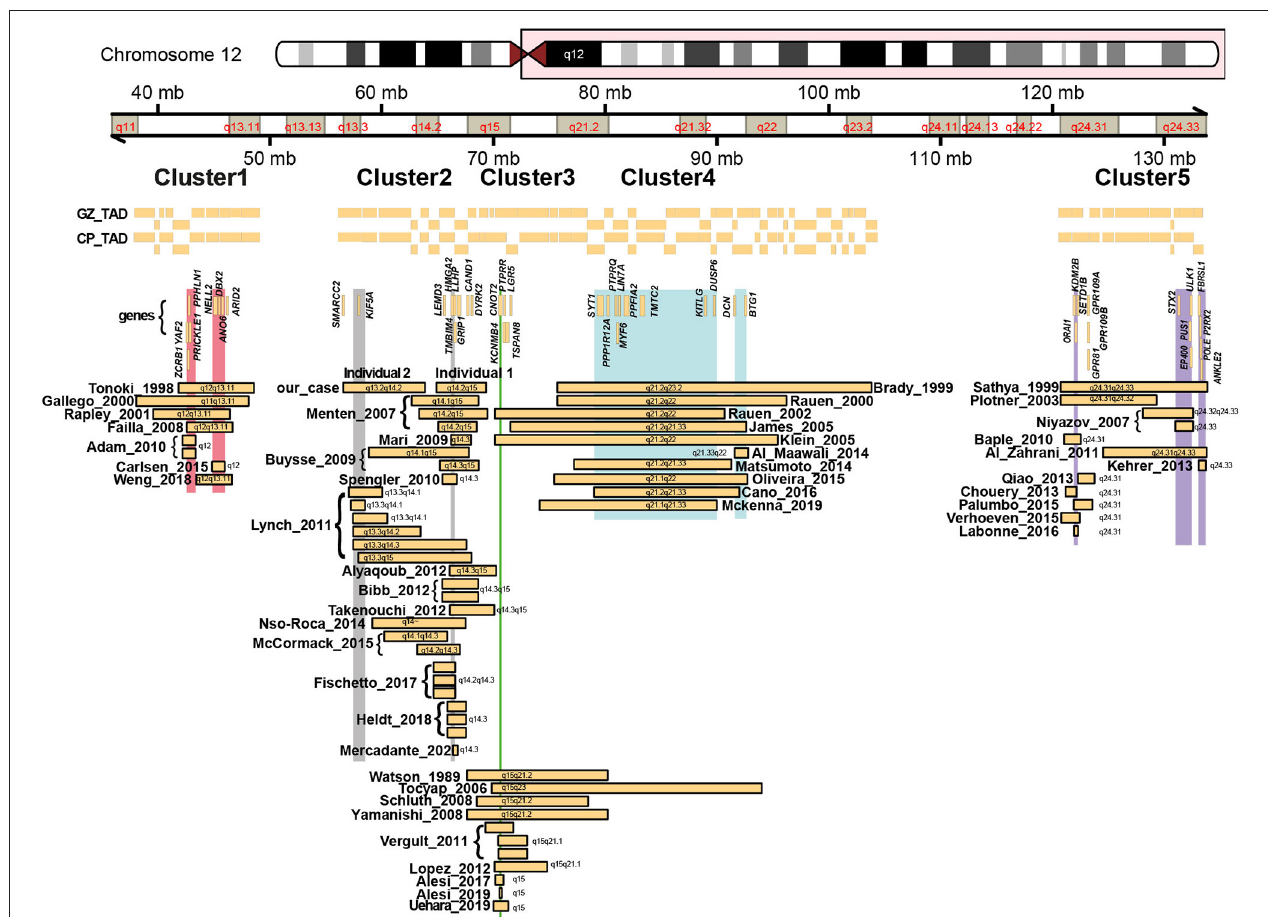
FIGURE 2 | Schematic overview of all previously reported deletions along chromosome 12q, with chromosome ideograms and bands indicated. Horizontal bars represent identified deletions that cluster amongst 5 regions, with names and years referring to the first author and year of publication from the studies in which these deletions were described. Also indicated are topological associated domains (Won et al., 2016) identified from chromatin conformation capture analysis of the germinal zone (GZ) and cortical plate (CP) from human fetal brain. Vertical bars represent small regions of overlaps shared between the different deletions. Genes discussed in the main text or in the Supplemental Materials are